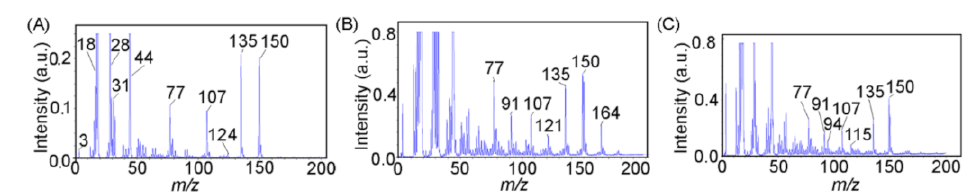
Figure 11. Mass spectra obtained by decomposition of FA/CeO 2 at a temperature of 250 ◦ C ( A ), 330 ◦ C ( B ), and 400 ◦ C ( C ).